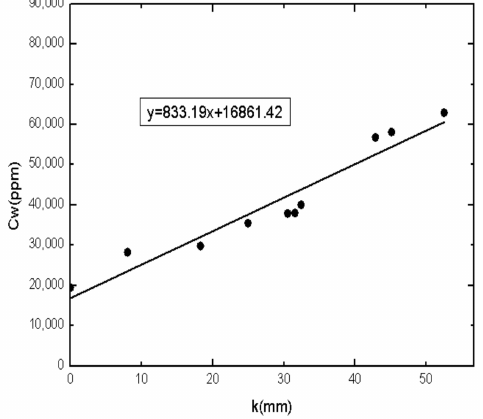
Figure 8. The relationship between k and C w ( S w = 65%).